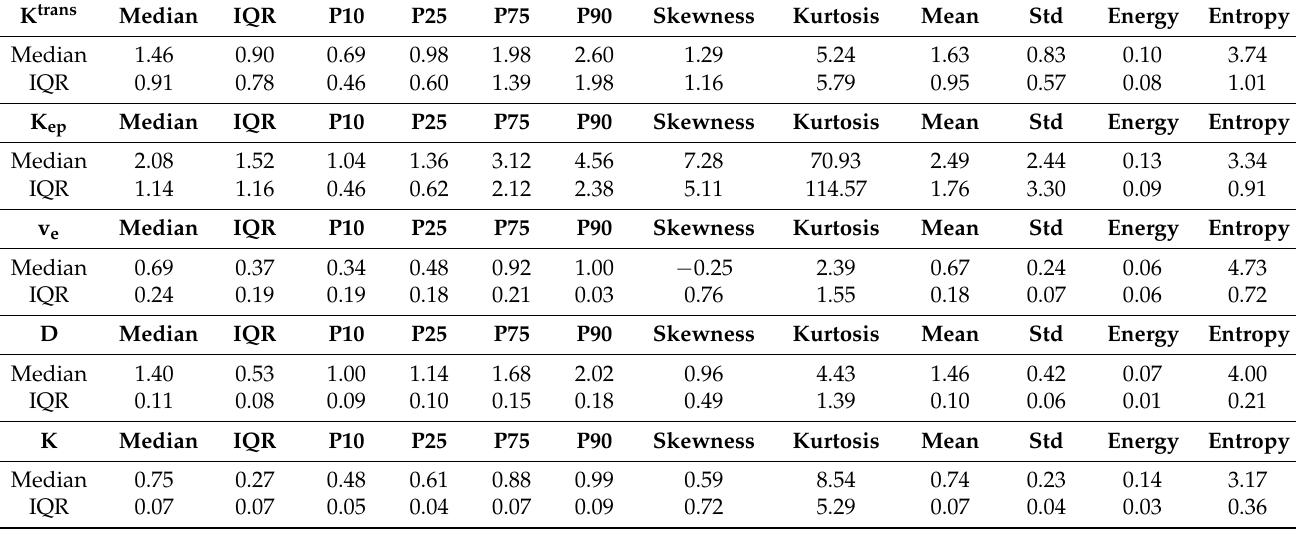
Table 2. Summary statistics of the DCE-MRI and DKI-derived